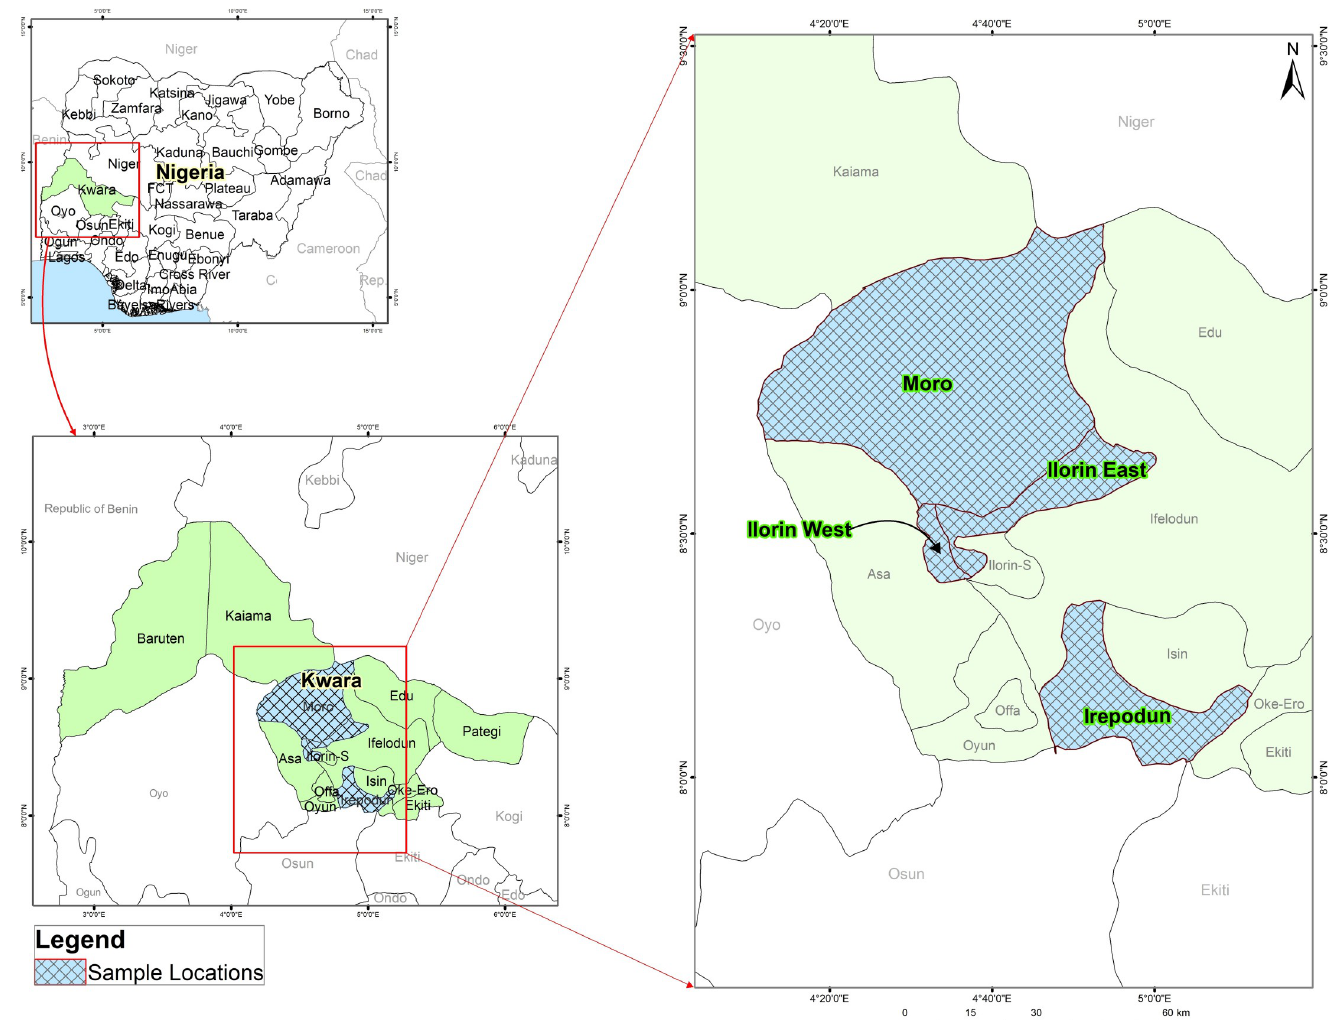
Fig 1. Spatial distribution of study areas in Kwara State,